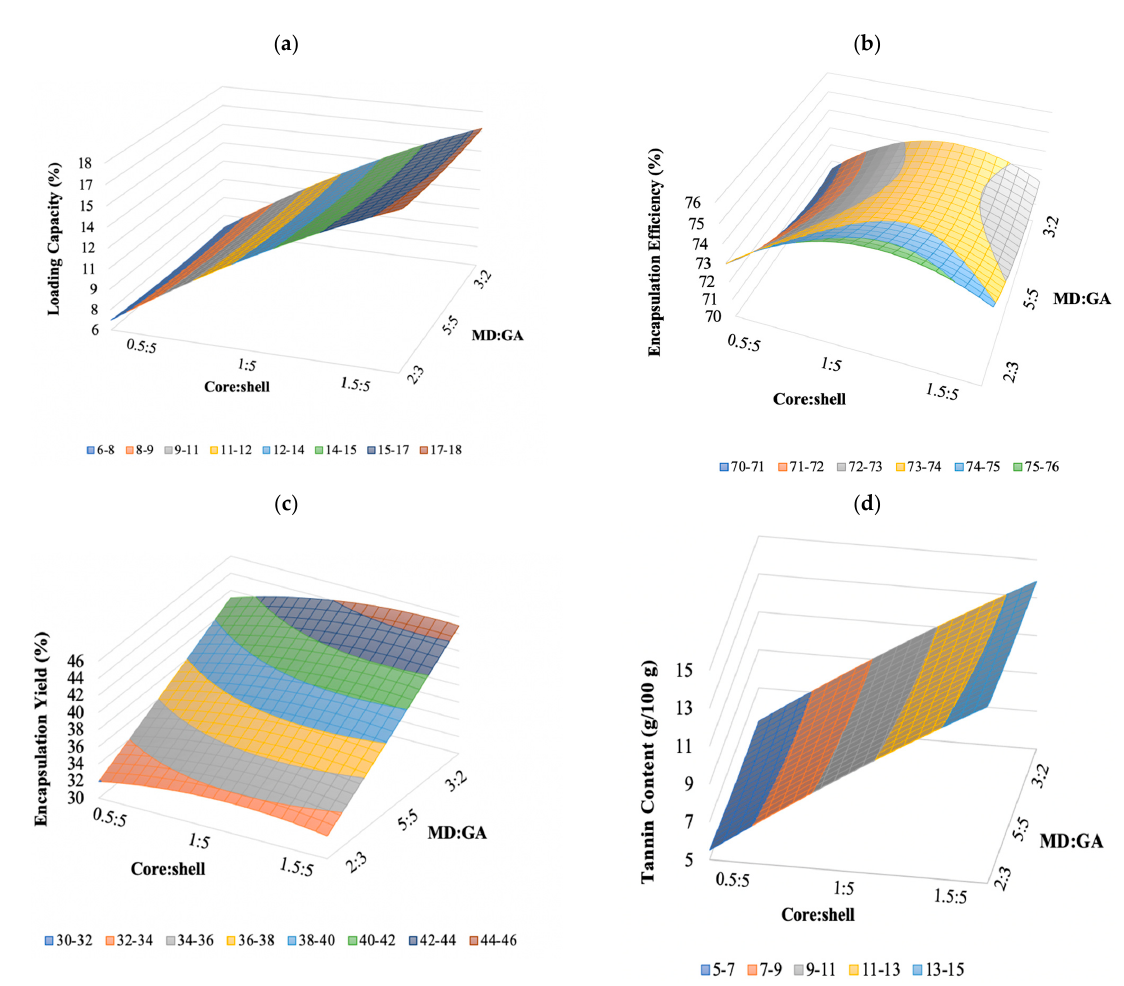
Figure 2. Response surfaces ( a – d ) showing influence of core:shell and MD:GA on LC ( a ), EE ( b ), EY ( c ), and TC ( d ).